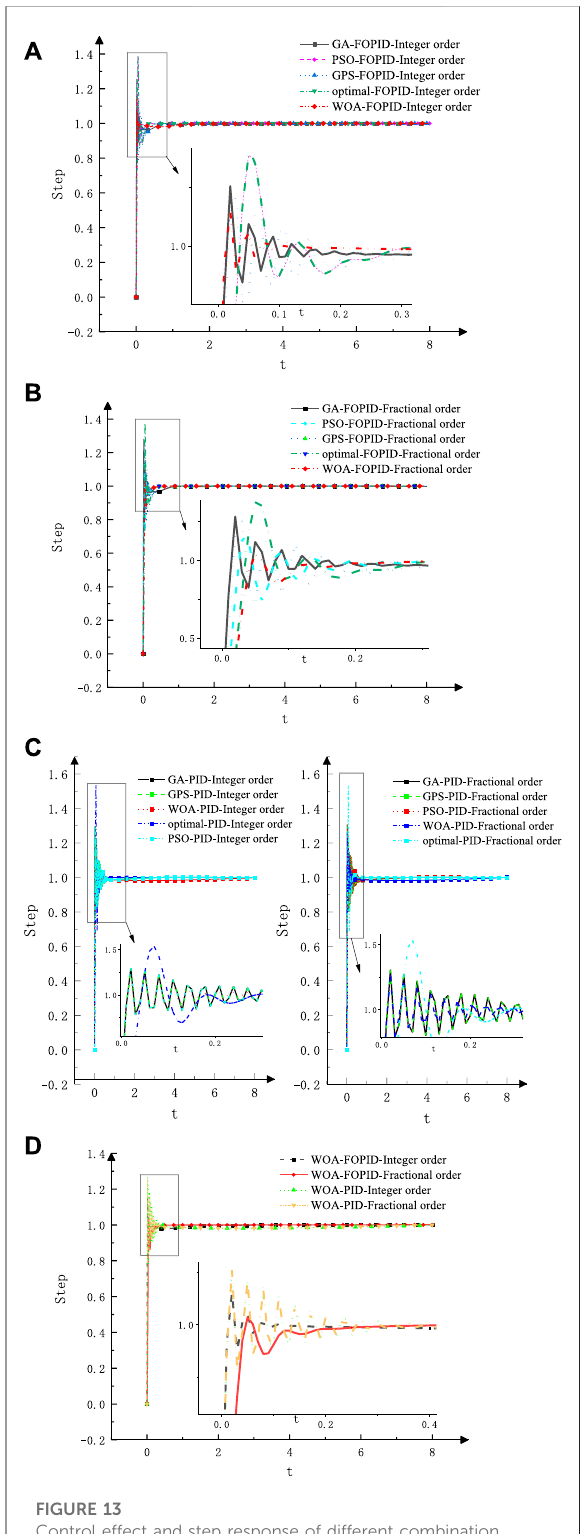
FIGURE 13 Control effect and step response of different combination strategies of the hydraulic motor. (A) The intelligent control